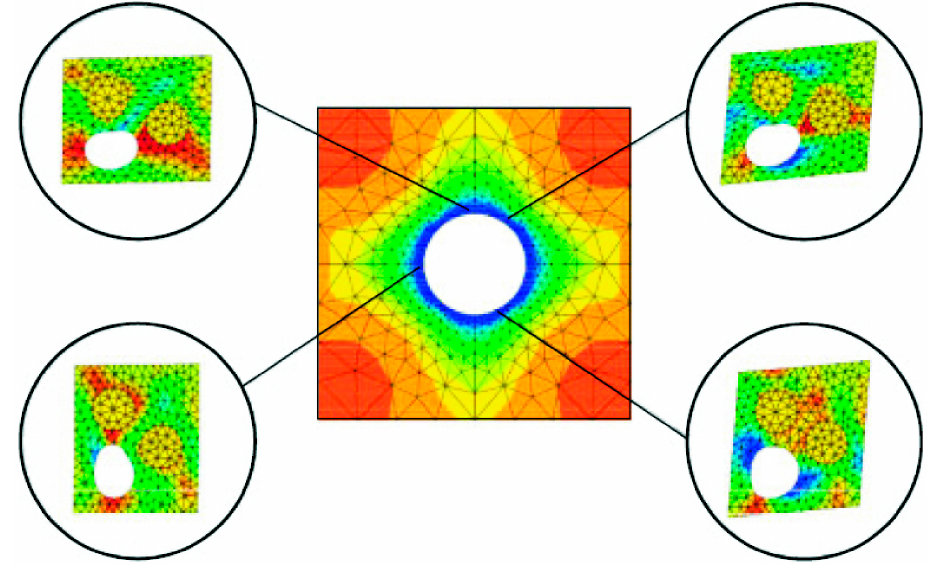
Figure 10. Multiscale analysis of finite strain plasticity: Equivalent plastic strains (figure taken with permission from [26]).